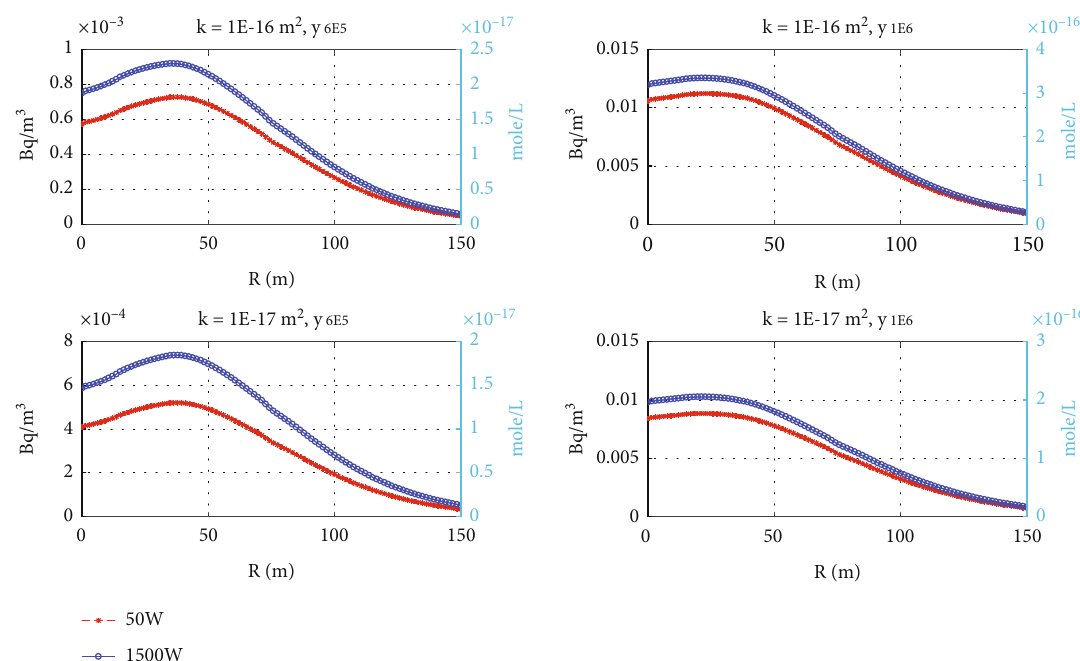
Figure 11: Longitudinal pro fi les of 79 Se activity concentration and annual dose at the water well ( Z = − 60 m ) along radial distance R for k = 10 − 16 m 2 (a, b) and k = 10 − 17 m 2 (c, d) considering 50 Watt (red) and 1500 Watt (blue) for the 0.5km deep borehole.